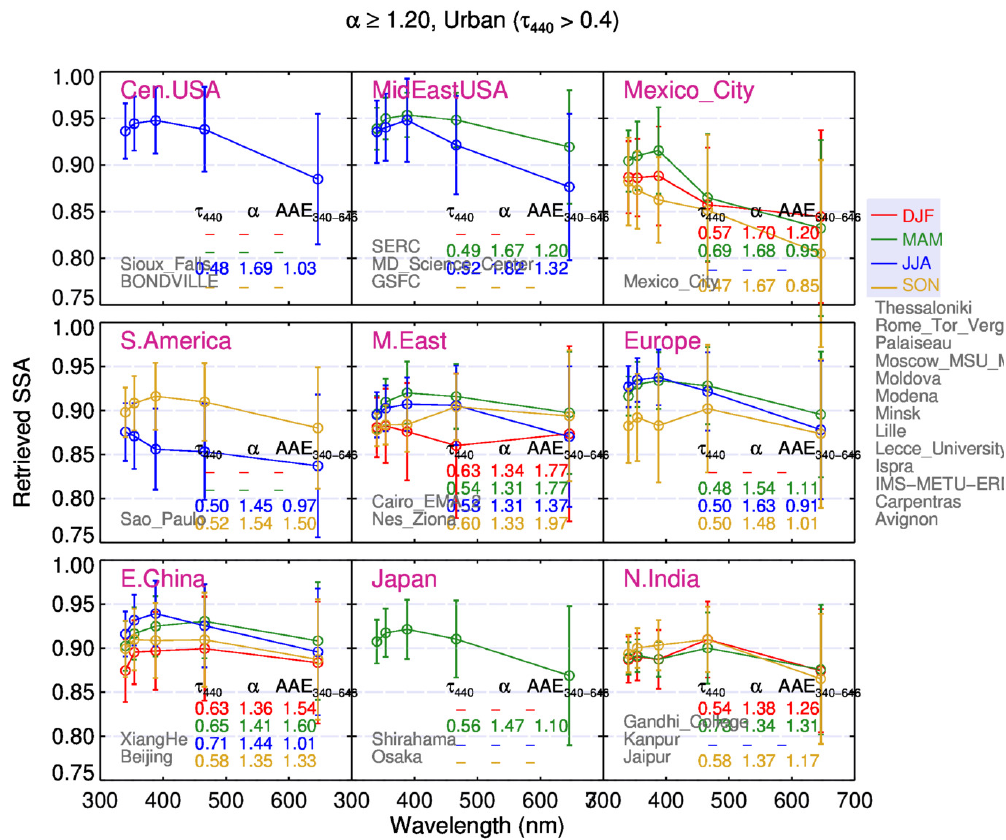
Figure 14. Seasonal average of spectral aerosol SSA derived for observations with τ 440 > 0 . 4 over regions dominated by fine-mode urban or mixture of aerosols. The error bars represent the standard deviation of the